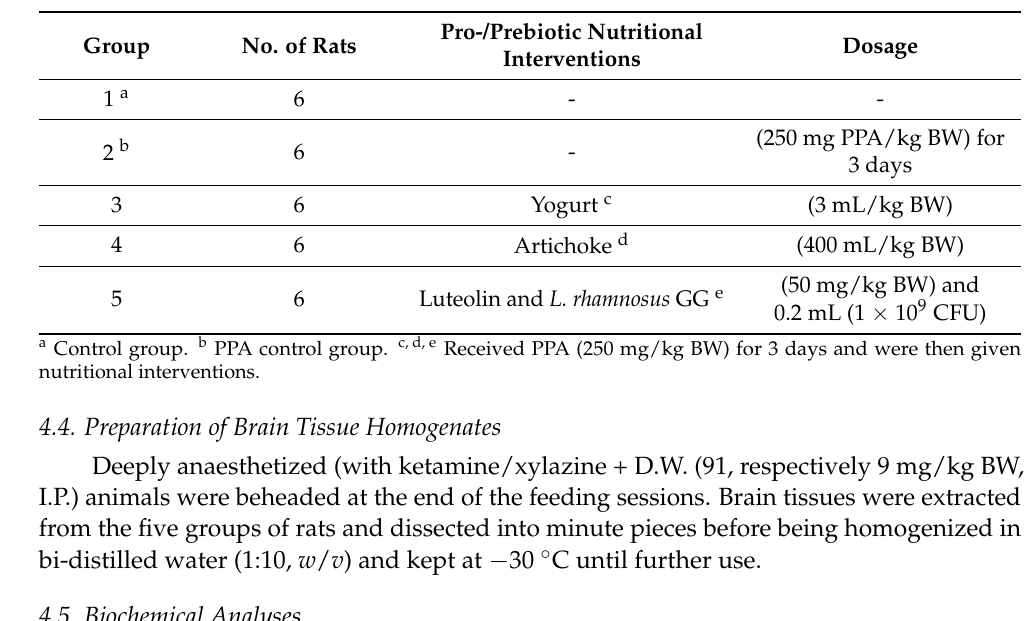
Table 5. Number of animals and the pro/prebiotic dosages fed to animals post orally administered PPA (250 mg /kg BW for 3 day). Group No. of Rats